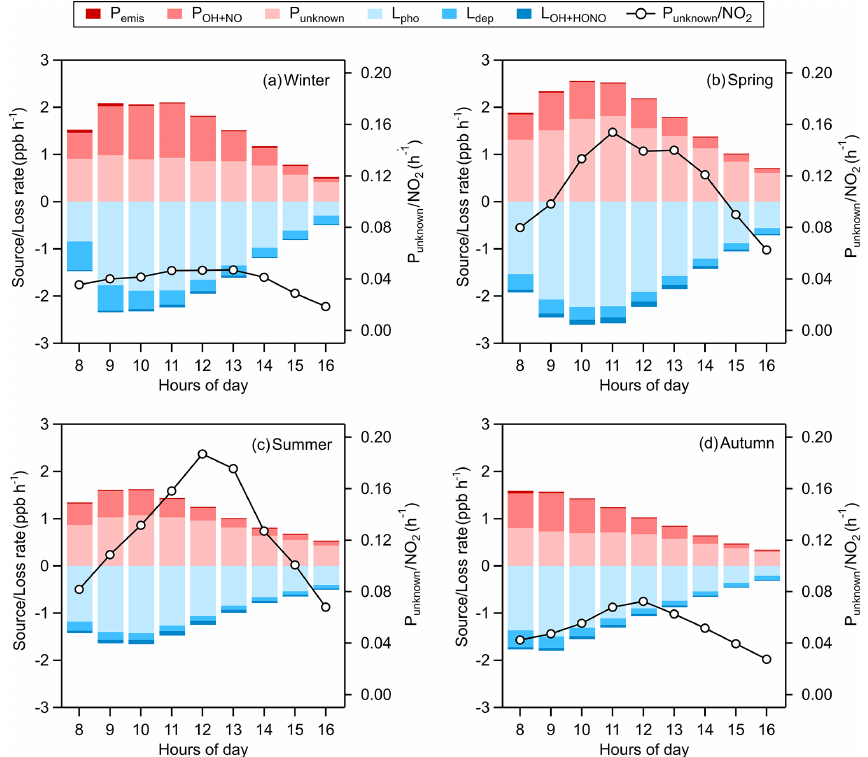
Figure 8. Averaged daytime HONO budgets and the missing source strength ( P unknown ) normalized by NO 2 in (a) winter, (b) spring, (c) summer, and (d) autumn. The mean values of P unknown around noontime (10:00–14:00LT) are 0.91ppbh − 1 in winter, 1.61ppbh − 1 in spring, 0.98ppbh − 1 in summer, and 0.68ppbh − 1 in autumn. Table 3. Correlations of P unknown against various parameters. Parameters Winter Spring Summer